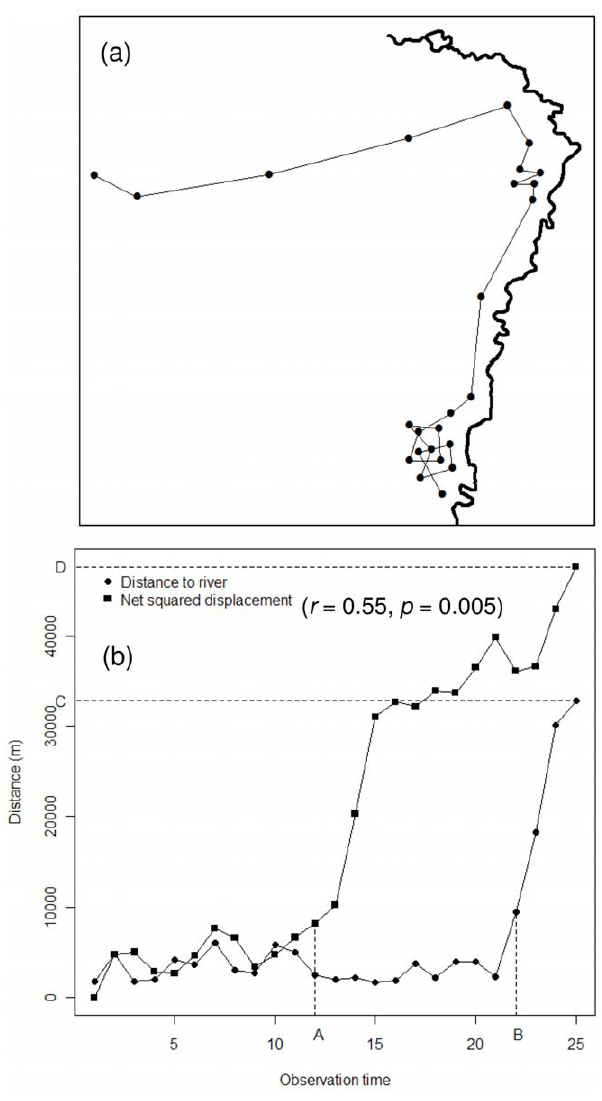
Figure 4. Inference of migratory behaviour from net-squared displacement. (a) Schematic of an animal moving alongside a permanent river (heavy line) during the dry season, and then migrating to a wet season range; and (b) the resulting plots of distance to river vs observation time and net-squared displacement (NSD) vs. observation time (A – onset of migration inferred from NSD; B – onset of migration inferred from distance to river; C – distance migrated inferred from distance to river; D – distance migrated inferred from